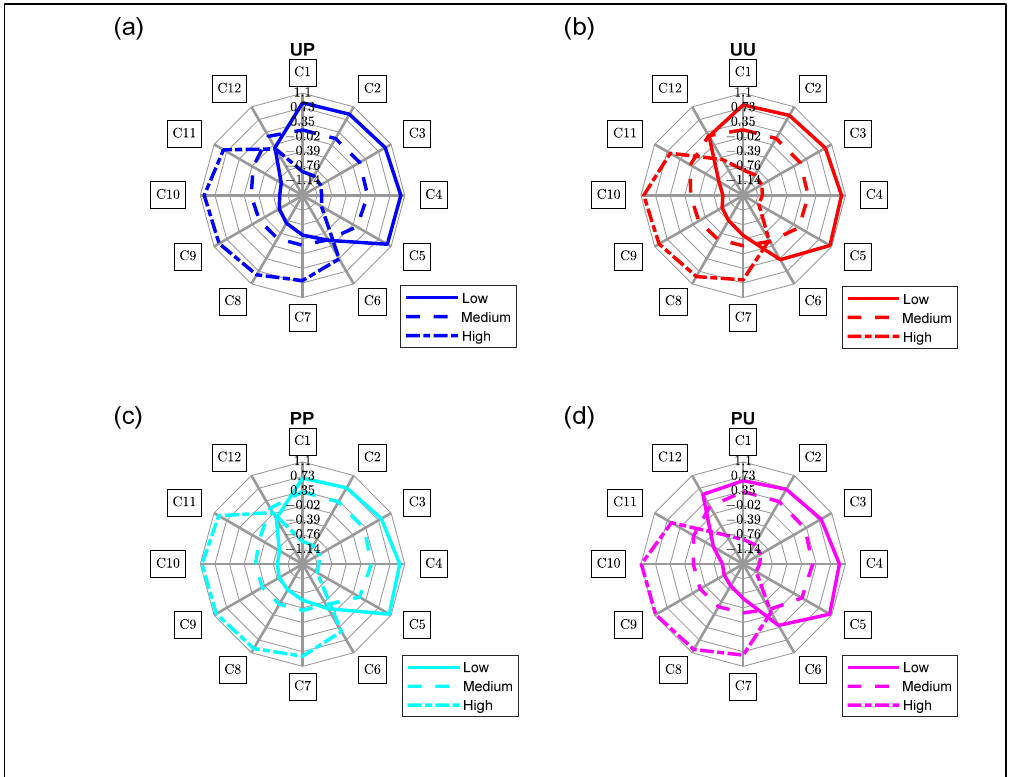
Figure 8. Aquagram for all configurations with different kiwifruit SSC (low, medium and high) for ( a ) Unpeeled Polarized, ( b ) Unpeeled Unpolarized, ( c ) Peeled Polarized and ( d ) Peeled Unpolarized. Solid Line—Low SSC, Dashed Line—Medium SSC and Dashed ‐ Dot Line—High SSC.